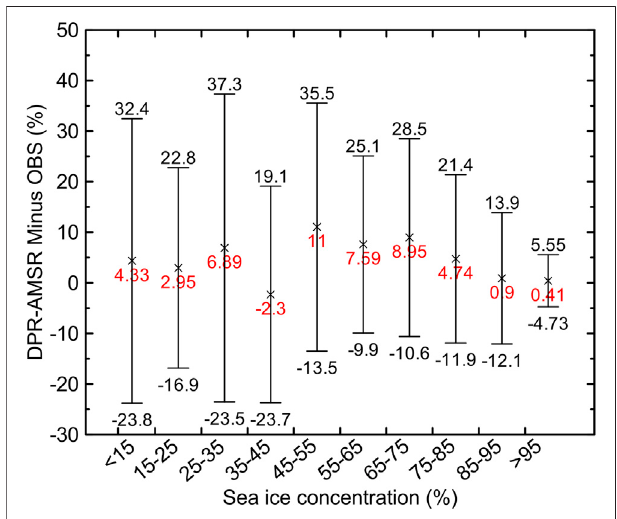
FIGURE 10 | Error bars of co-located daily average sea ice concentration from ship-based visual observations (OBS) and from DPR- AMSR. Data were from 2002 to 2011. sea ice concentrations were separated into the following bins: < 15%, 15% – 25%, 25% – 35%, 35% –